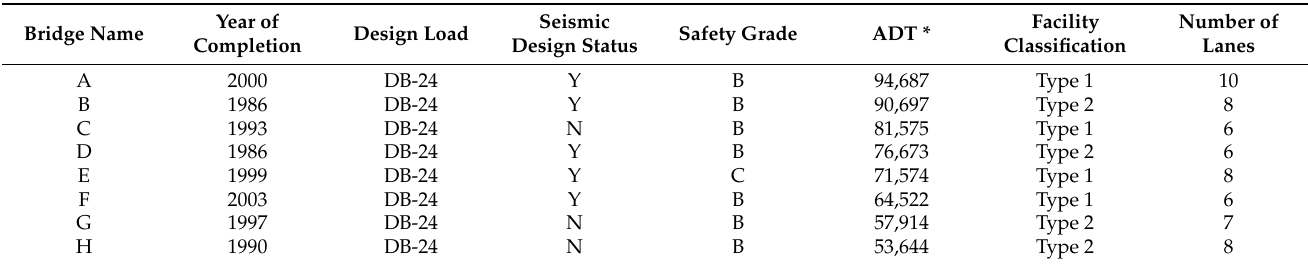
Table 6. Data on the eight bridges to which the maintenance priority model could be applied.